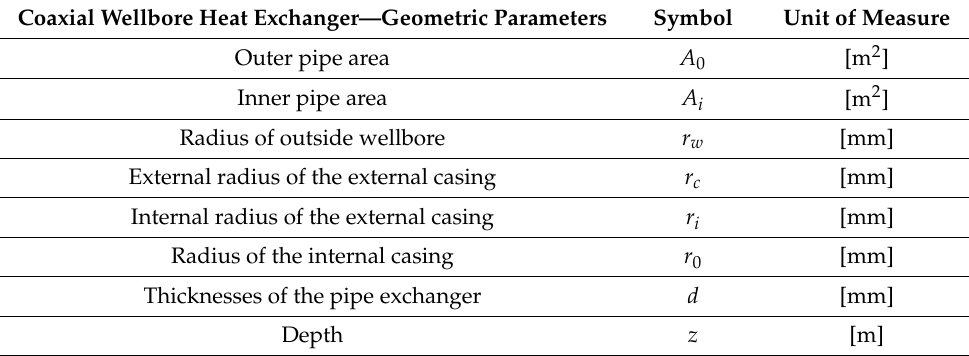
Figure 5. Schematic representation of a coaxial Wellbore Heat Exchanger (WBHE). Table 4. Coaxial WBHE—geometric